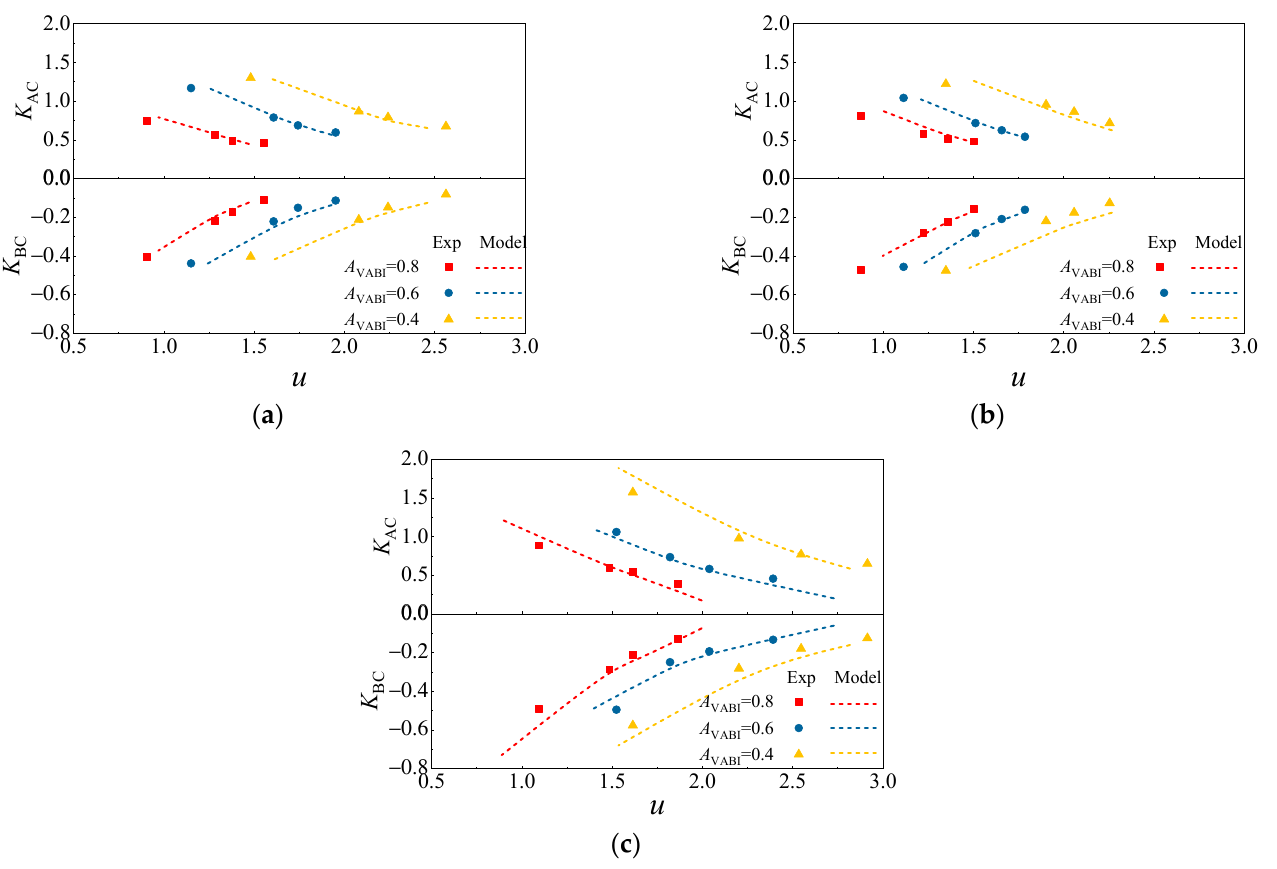
Figure 20. The variation in the combining flow loss with total pressure ratio: ( a ) α VABI = 35°; ( b ) α VABI = 25°; ( c ) α VABI = 15°.